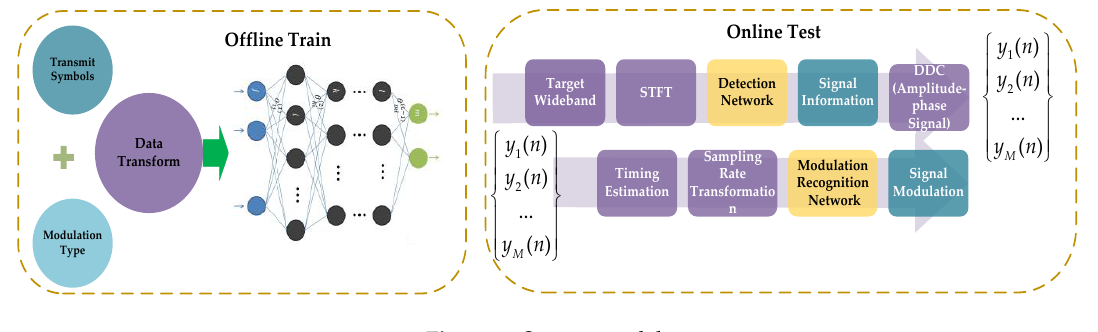
Figure 9. System model.